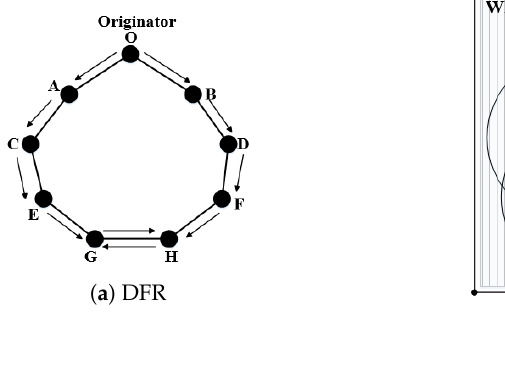
Figure 10. Difference between DFR and